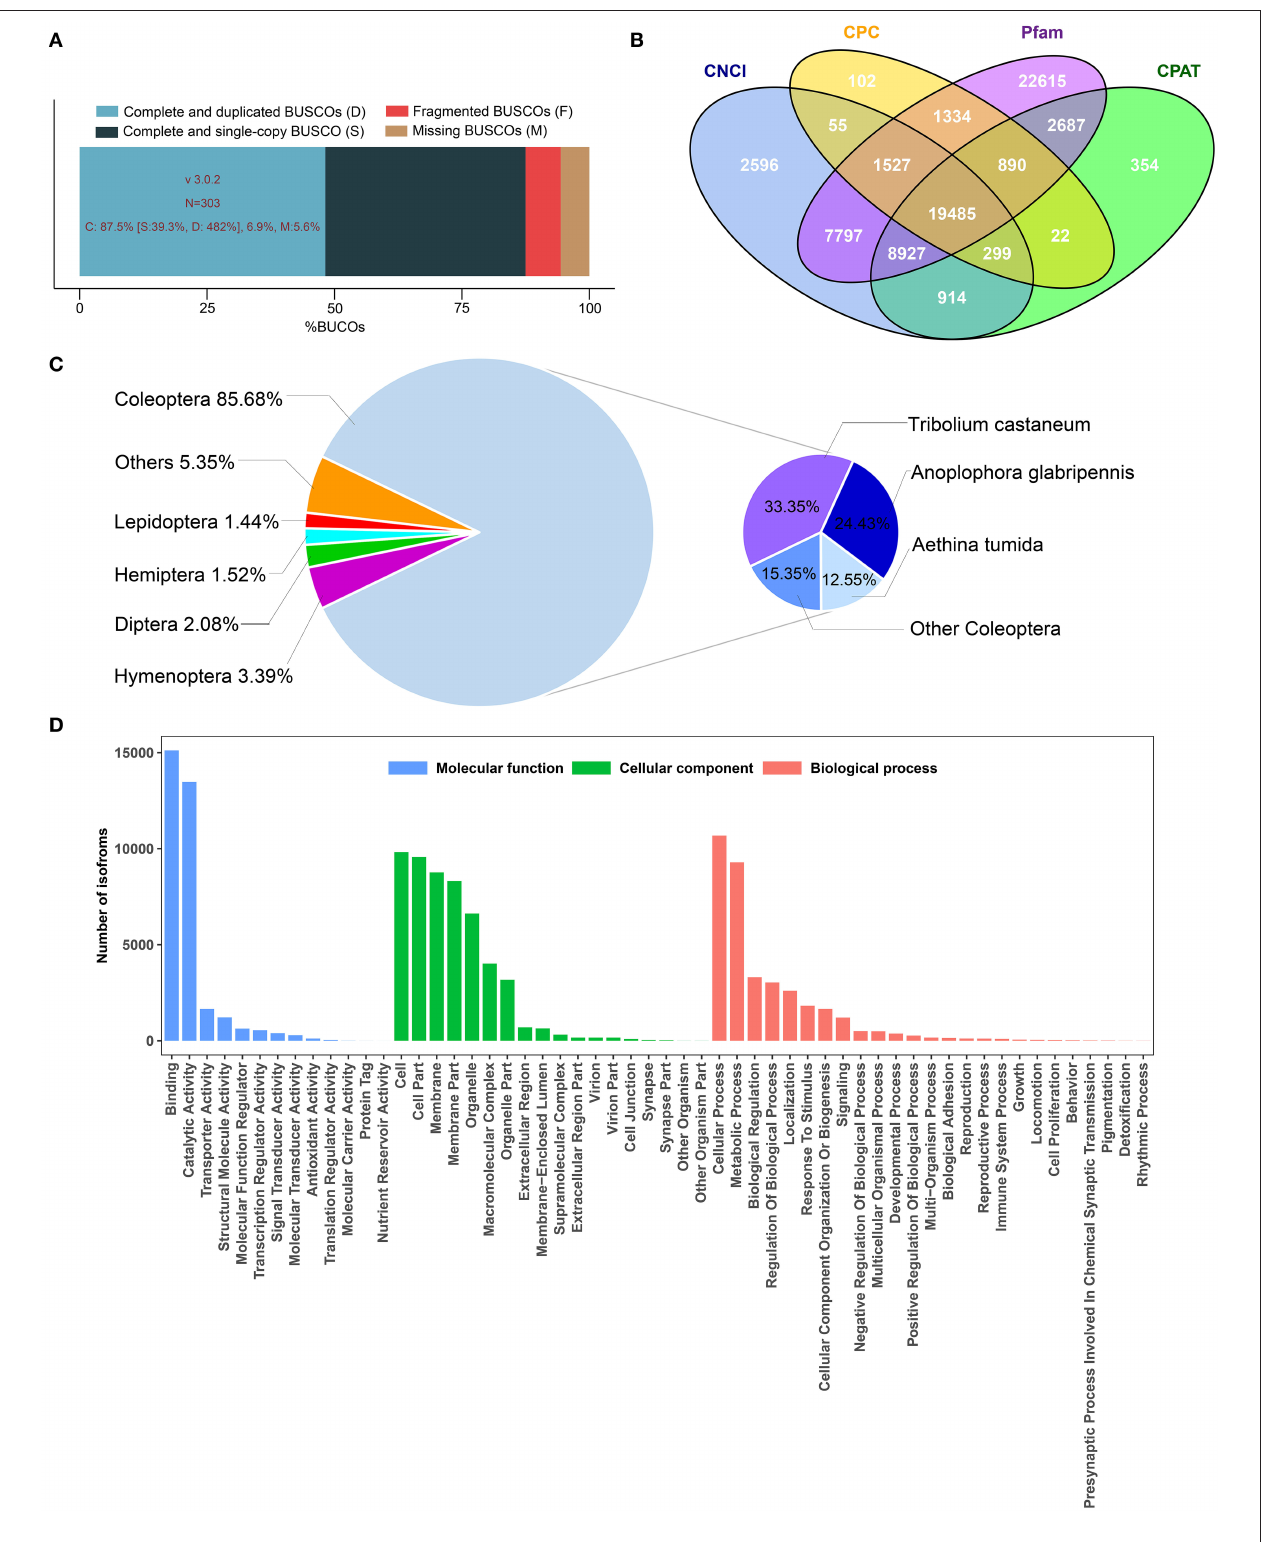
FIGURE 1 | Summary of transcriptome results obtained from PacBio sequencing platforms. (A) BUSCO analysis show proportions classified as complete (C, blues), complete duplicated (D, light blue), complete single-copy (S, dark blue), fragmented (F, red), and missing (M, brown). (B) Long non-coding RNAs were predicted by Calculator (CPC), Coding-Non-coding Index (CNCI), Coding Potential Assessment Tool (CPAT), and Pfam protein structure domain analysis. (C) Homologous species distribution of H. axyridis annotated in the NR database. (D) GO classification show transcripts were classified into three main categories: Molecular function, cellular component, and biological